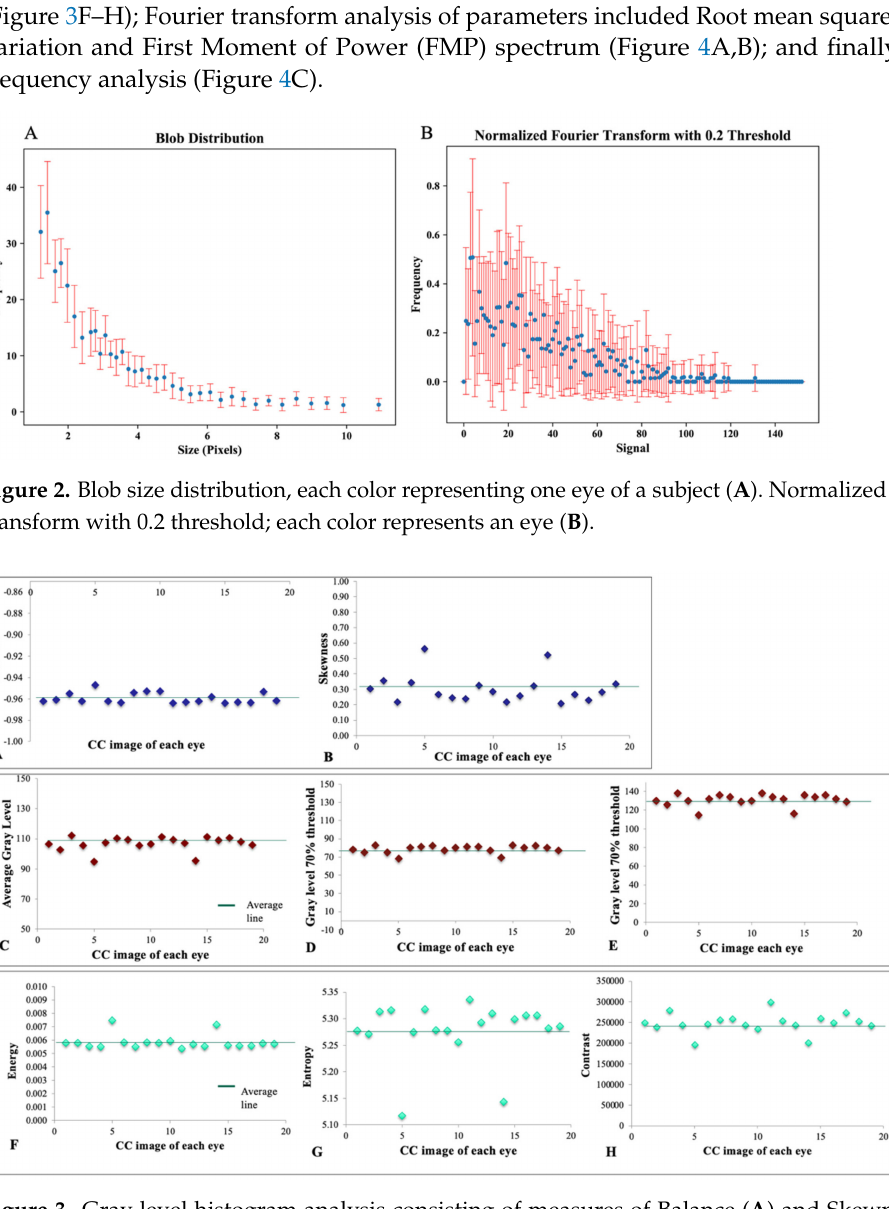
Figure 3. Gray level histogram analysis consisting of measures of Balance ( A ) and Skewness ( B ). Absolute value of gray levels in OCTA images of choriocapillaris in each eye. These set of measures included average gray level ( C ), gray level with 30% ( D ) or 70% threshold ( E ). Spatial relationship among gray levels in OCTA images of choriocapillaris in each eye. Energy ( F ), entropy ( G ), and contrast ( H ) were measured in this category of